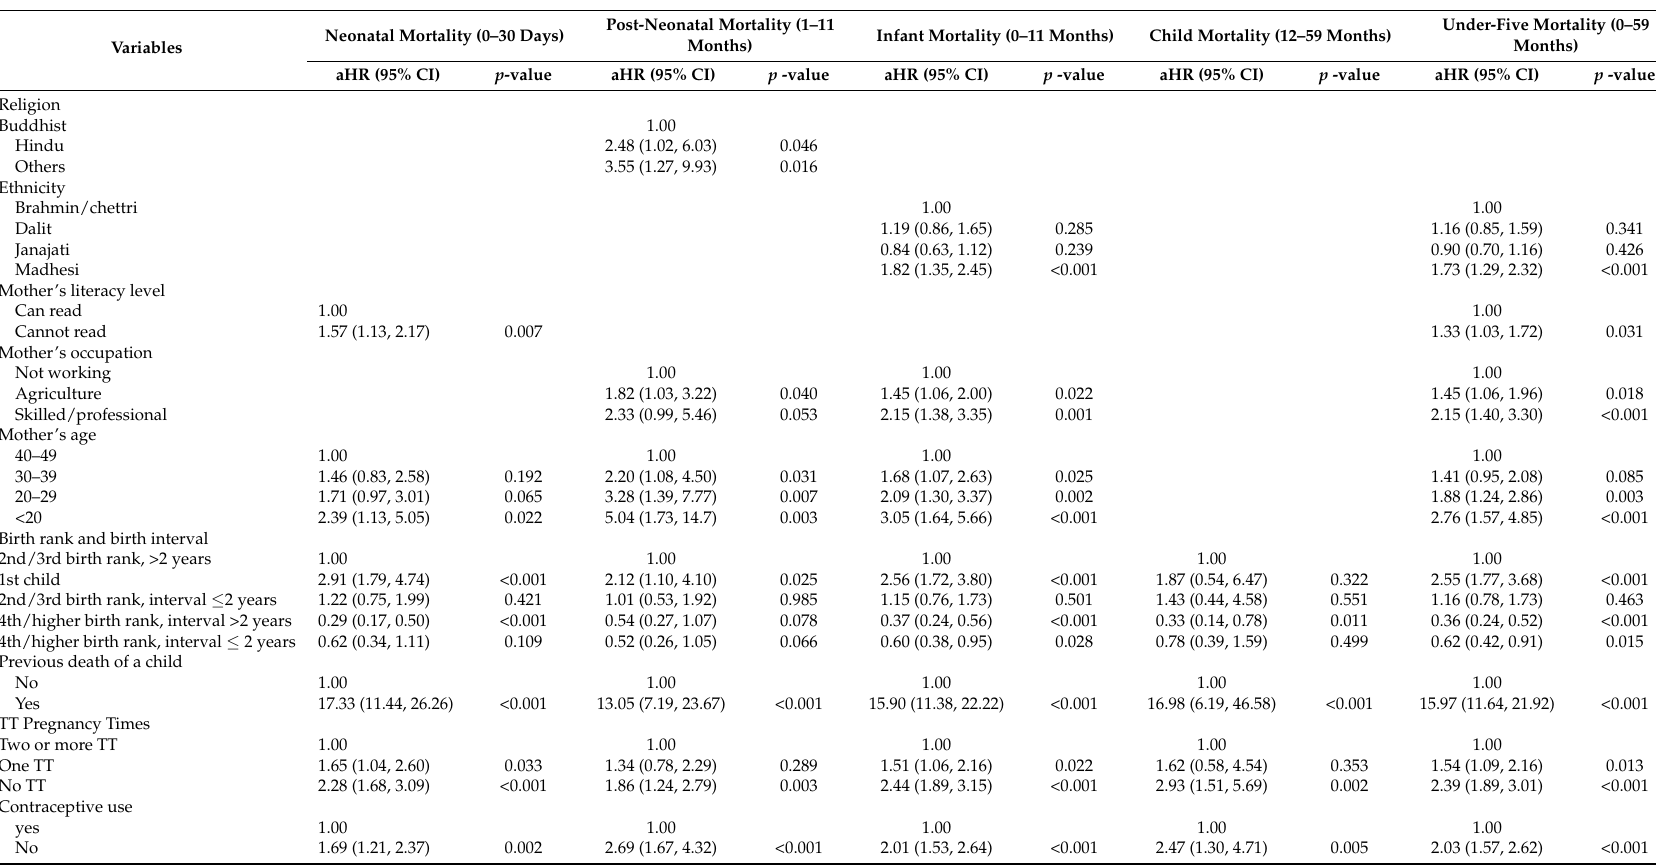
Table 2. aHR (95% CI) for factors associated with neonatal, post-neonatal, infant, child and under-five mortality in Nepal, 2001–2016, ( n = 15,750).